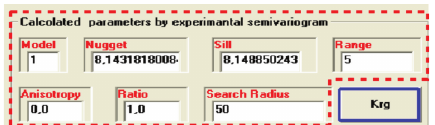
Figure 18: The KA kriging configuration panel with the numerical results of the interpretation and, in blue, the kriging starting button.